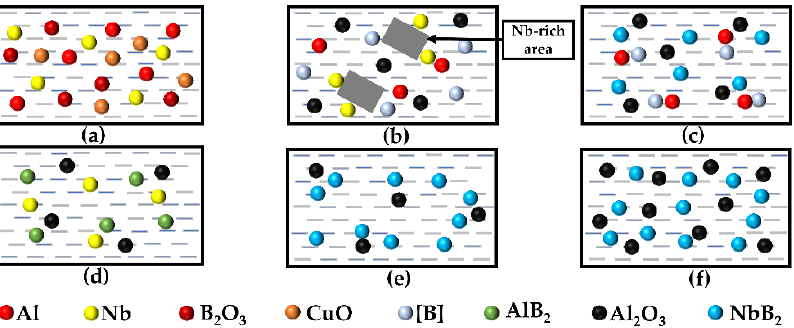
Figure 5. The Al–Nb–B 2 O 3 –CuO system in situ reaction mechanism: ( a ) aluminum melting and dispersion in the reactants, ( b ) the dissolution of Nb in Al to form the Al–Nb melt and the aluminothermic reaction, ( c ) the reaction of Nb with [B] to form NbB 2 particles, ( d ) the generation of intermediate product AlB 2 , ( e ) the reaction of AlB 2 with Nb to form NbB 2 particles, and ( f ) in situ NbB 2 and Al 2 O 3 particles to strengthen the melt of aluminum matrix composites.